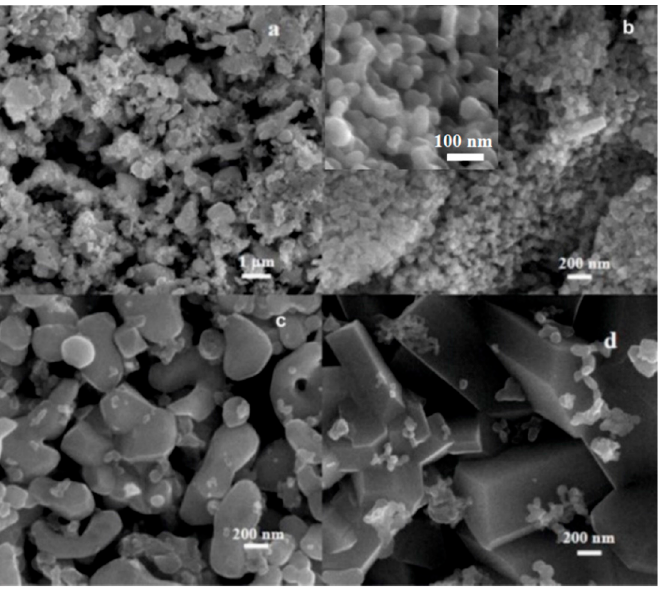
Figure 3. SEM micrographs of CuW1 showing mixed states of aggregation ( a ) and different regions of the sample with distinct particle sizes ( b – d ) with a higher magnification inset in ( b ). SEM micrographs of CuW2 were recorded simultaneously from secondary elec- trons—SE (Figure 4a, showing that the intensity is proportional only to the topographic contrast) and back-scattered electrons—BSE (Figure 4b, showing that the Z-contrast inten- sity is proportional to the atomic weight). The similarity of both images indicates the ho- mogeneity of the elemental chemical composition, i.e., a single phase structure. The pri- mary nanoparticle sizes of ~50 nm are in good agreement with the typical nanocrystallite size calculated from the XRD pattern. Higher resolution images (Figure 4c–e) reveal that primary nanoparticles aggregate in chains, forming 1D “nanostick”-like structures that tend to align forming agglomerates that reach sizes of up to few microns. Figure 4. SEM micrographs of CuW2: ( a ) Secondary emission (SE) and ( b ) back-scattered electrons (BSE) images taken simultaneously from the same region and higher resolution, ( c ) SE, ( d ) BSE micrographs, and ( e ) higher magnification images. The microstructural analysis of CuW3 by means of SEM is presented in Figure 5.